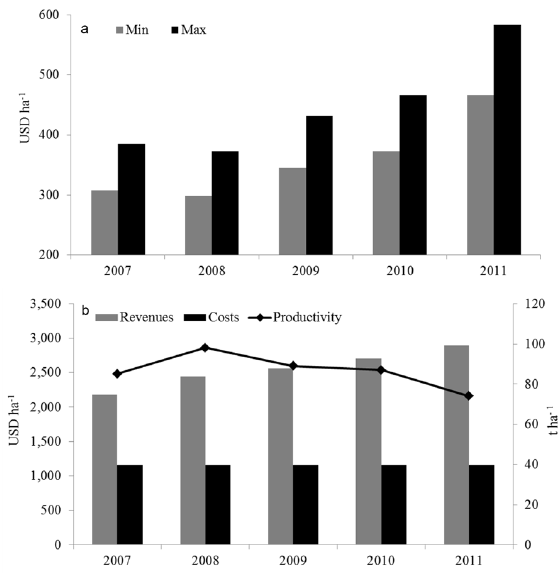
Figure 4 - Sugarcane profitability of farmers for payment contracts under land lease ( a ) considering the TRS (Total Recoverable Sugar) in 12 or 15 tons of sugarcane per hectare or for independent suppliers ( b ) in the municipalities of Quirinópolis and Gouvelândia, Goiás, Brazil. Sources: estimated from IBGE (2012); Consecana (2012). Revenues and production costs were inflation corrected (IPCA) in Reais (R$) and converted to US dollar (USD 1 = R$